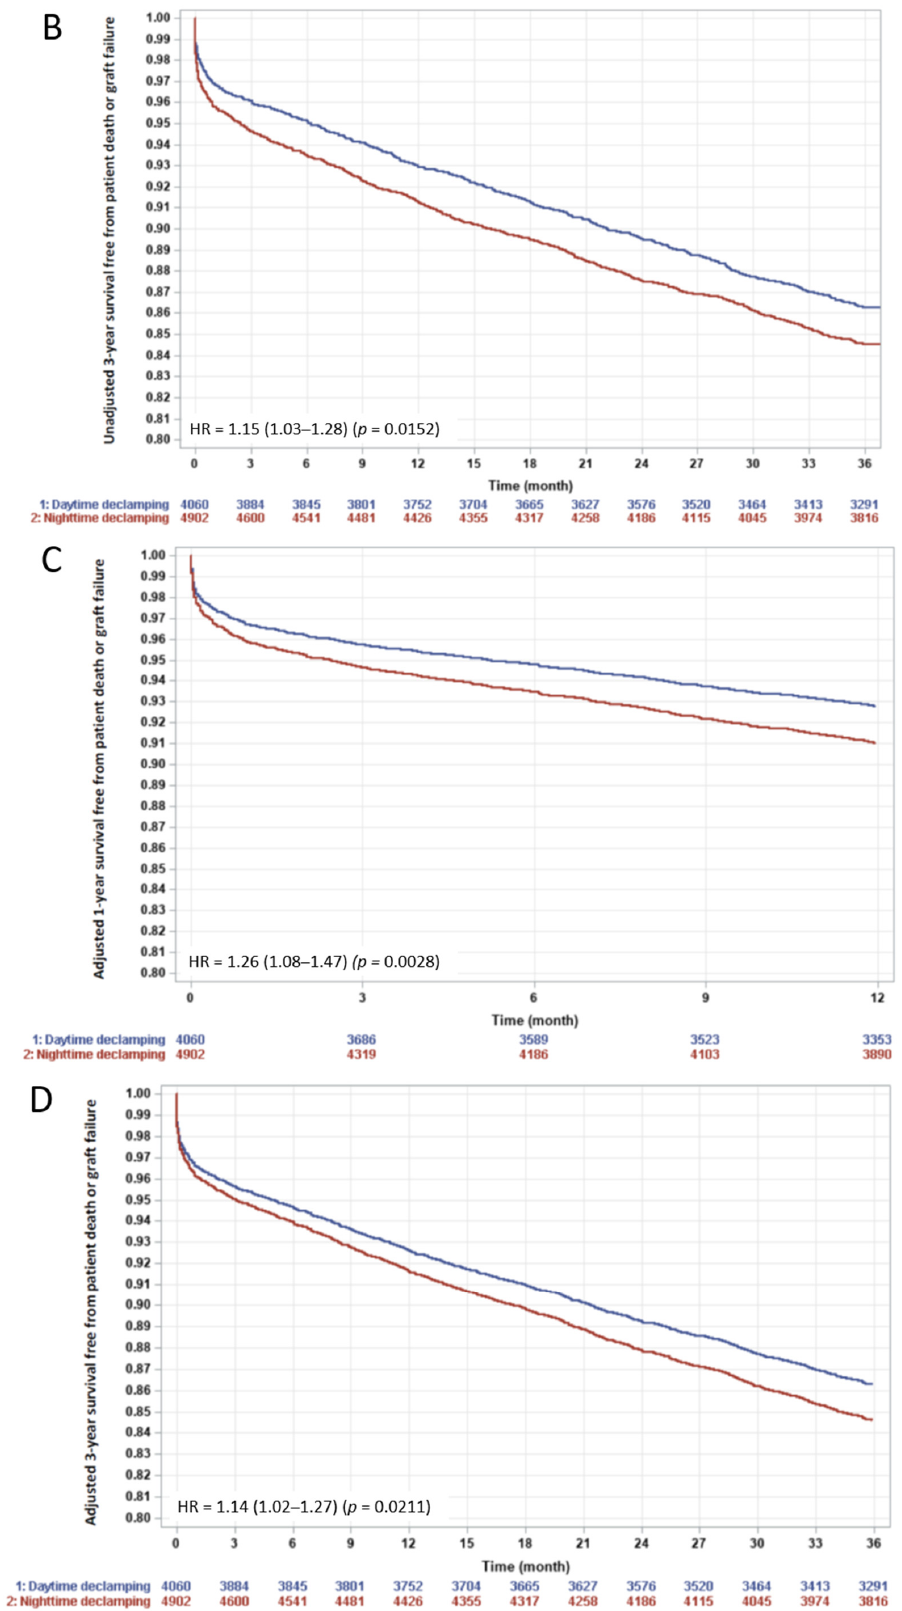
Figure 3. One- and 3-year survival free from patient death or graft failure after night- versus day-time declamping. Non-adjusted ( A , B ) and adjusted ( C , D ) survival curves. Day-time declamping in blue and night-time declamping in red. p -value by log-rank